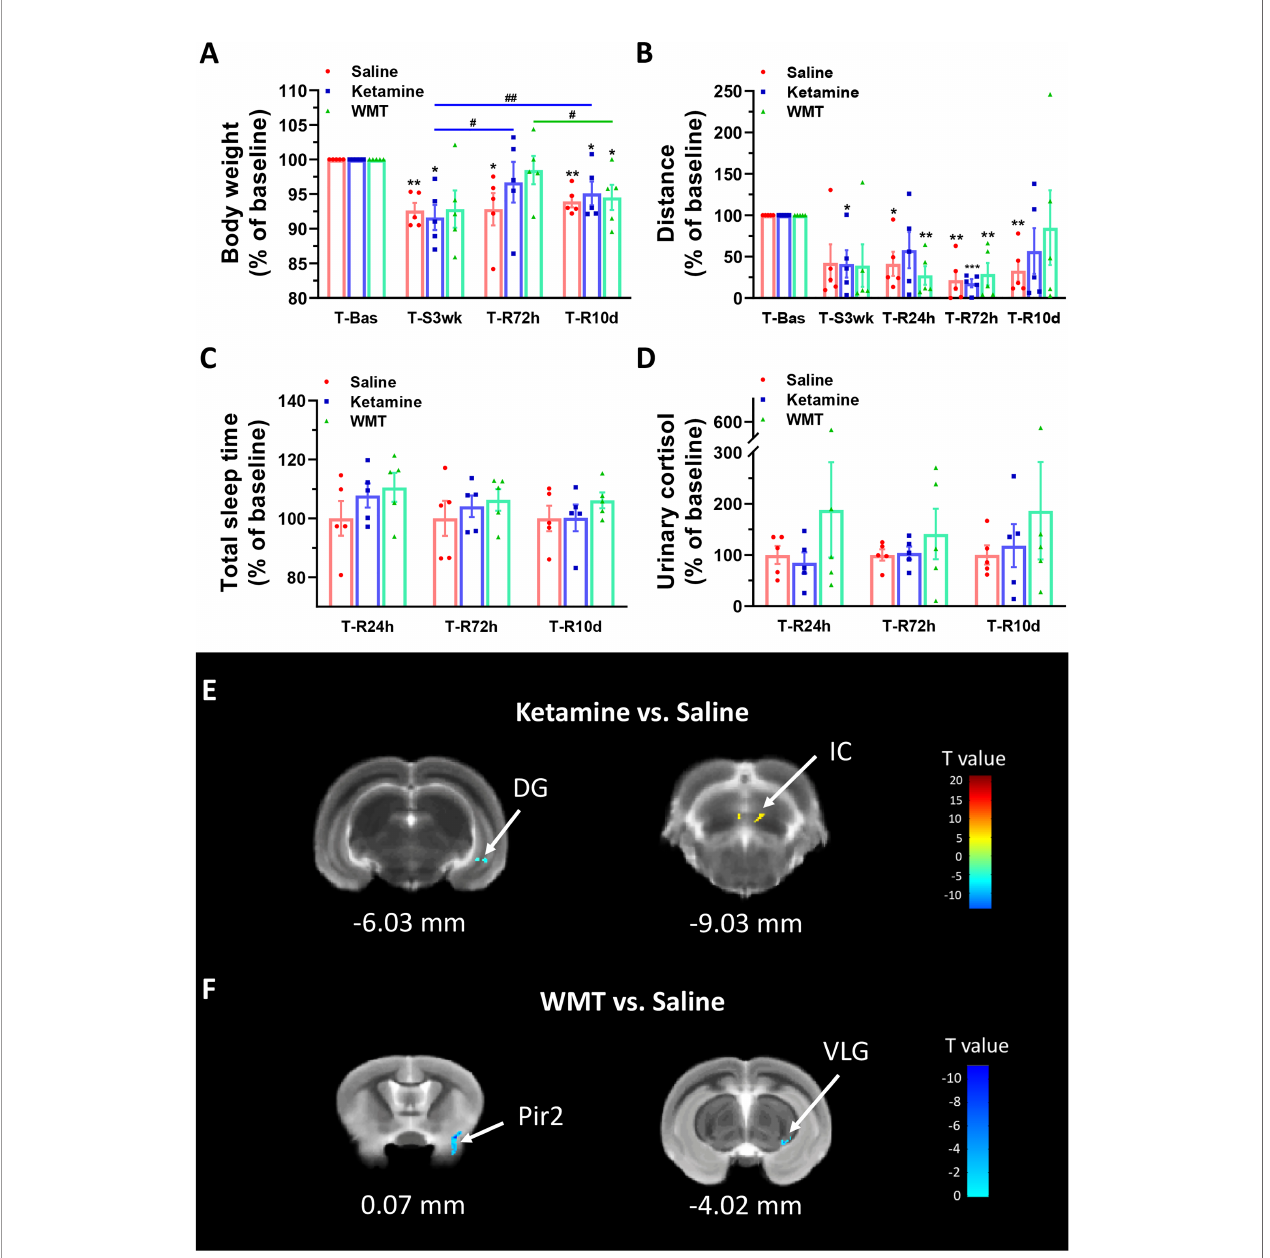
FIGURE 4 | Physiological responses and changes in grey matter density of brain structure in tree shrews under different treatments during the recovery phase. (A, B) Body weight and distance travelled in the open fi eld box under saline, ketamine and WMT. They were normalized with the values in the baseline (T-Bas) by using paired-samples t test. (A) In the saline group (the red column, N = 5), the body weight was decreased in T-S3wk [t(4) = 6.735, p = 0.003], T-R72h [t(4) = 3.075, p = 0.037] and T-R10d [t(4) = 7.093, p = 0.002]. In the ketamine group (the blue column, N = 5), the body weight was temporarily recovered at T-R72h to a baseline level and was improved compared to T-S3wk [t(4) = 3.509, p = 0.025], then dropped a bit yet was still higher at T-R10d [t(4) = 6.945, p = 0.002] compared to T-S3wk. In the WMT group (the green column, N = 5), tree shrews gained more weight in T-R72h than T-R10d [t(4) = 4.916, p = 0.008]. (B) In the saline group (the red column, N = 5), distance travelled in the open fi eld box was decreased in T-R24h [t(4) = 4.013, p = 0.016], T-R72h [t(4) = 6.585, p = 0.003] and T-R10d [t (4) = 5.216, p = 0.006]. In the ketamine group (the blue column, N = 5), the distance was decreased in T-S3wk [t(4) = 3.532, p = 0.024] and T-R72h [t(4) = 17.117, p = 0.000]. In the WMT group (the green column, N = 5), the distance showed a decrease in T-R24h [t(4) = 6.457, p = 0.003] and T-R72h [t(4) = 5.293, p = 0.006]. (C, D) Total sleep time (C, N = 5/group) and morning urinary cortisol (D, N = 5/group) of tree shrews under saline, ketamine and WMT treatments. They were normalized by comparing with the saline group to avoid errors from humans and instruments. (E) The signal from DG (dentate gyrus of the hippocampus) decreased but that from IC (inferior colliculus) increased after ketamine administration (N = 3/group). (F) The signals from Pir2 (piriform cortex, layer 2) and VLG (ventral lateral geniculate nucleus) decreased after WMT (N = 3/group). Error bars show the SEM. *means compared with control in baseline phase, *p <0.05, **p <0.01, ***p <0.001. # means compared between the stress and recovery phase, #p <0.05, ##p